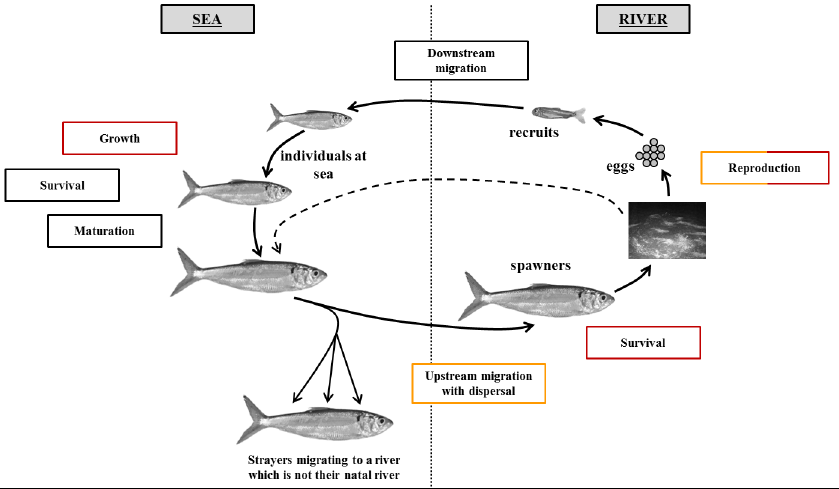
Fig 1. Conceptual diagram of the life cycle of anadromous species (adjusted to allis shad) represented in the GR3D model. Red boxes depicted the processes in GR3D that were influenced by temperature and orange boxes the ones that were linked to the surface area of the drainage basin. The figure was adapted from [26] for illustrative purpose